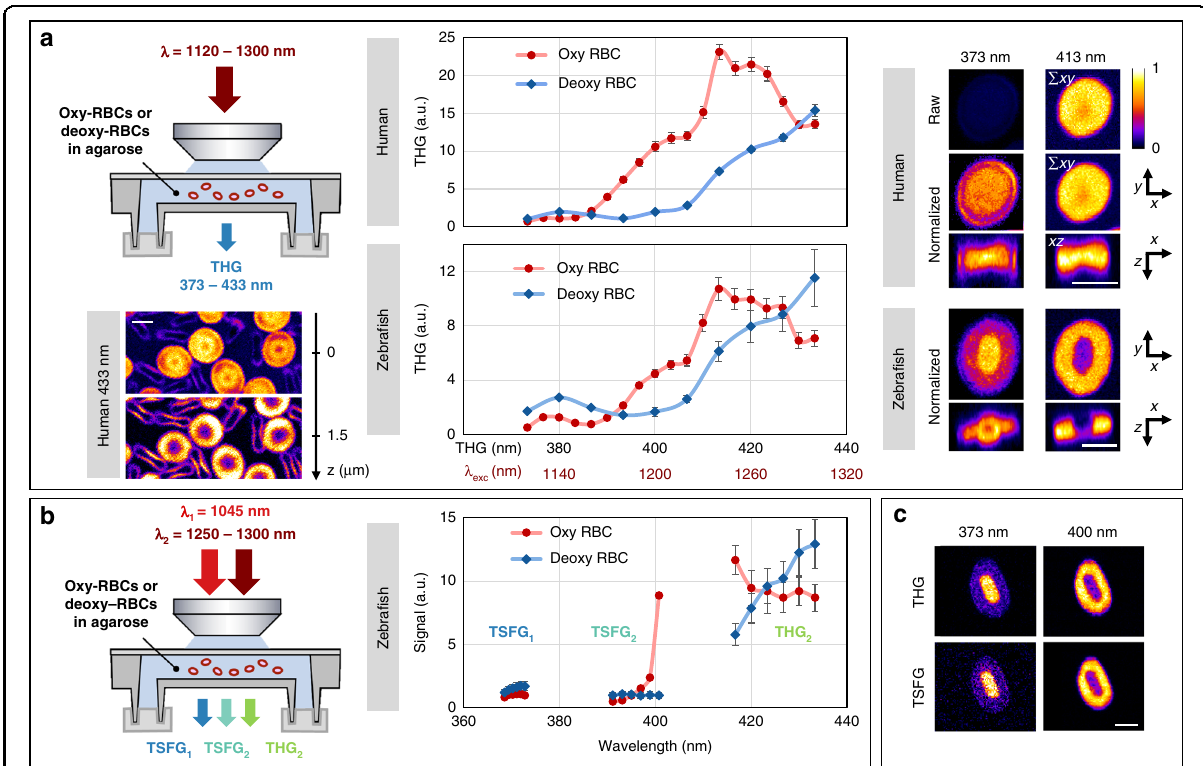
Fig. 2 THG and TSFG spectral imaging of red blood cells near the Soret band. Average THG and TSFG signal from human and zebra fi sh RBCs in oxygenated and deoxygenated states. 3D images of individual RBCs were recorded at successive excitation wavelengths in the 1120 – 1300 nm range and normalized by the excitation power and pulse duration. A 10 – 20× signal enhancement is observed when the emission wavelength matches the Soret band, attributed to three-photon resonance. a Single-beam THG spectra and representative images at 433 nm (left, single planes) and at 373 and 413 nm (right, projections). The spectra were obtained from measurements on N = 7 human and N = 14 zebra fi sh RBCs. The images are normalized to their maxima except in the fi rst line to illustrate the signal enhancement. The images shown are projections of the central planes along z and y directions. Unlike human RBCs, zebra fi sh RBCs possess a nucleus where no resonance is observed. b Dual-beam THG-TSFG spectra of zebra fi sh RBCs acquired by tuning the OPO beam in the range 1250 – 1300 nm. c Contrast similarity of single-beam THG (top) and TSFG (bottom) images. TSFG images at 373 and 401 nm were acquired simultaneously. Scale bars: 5 μ